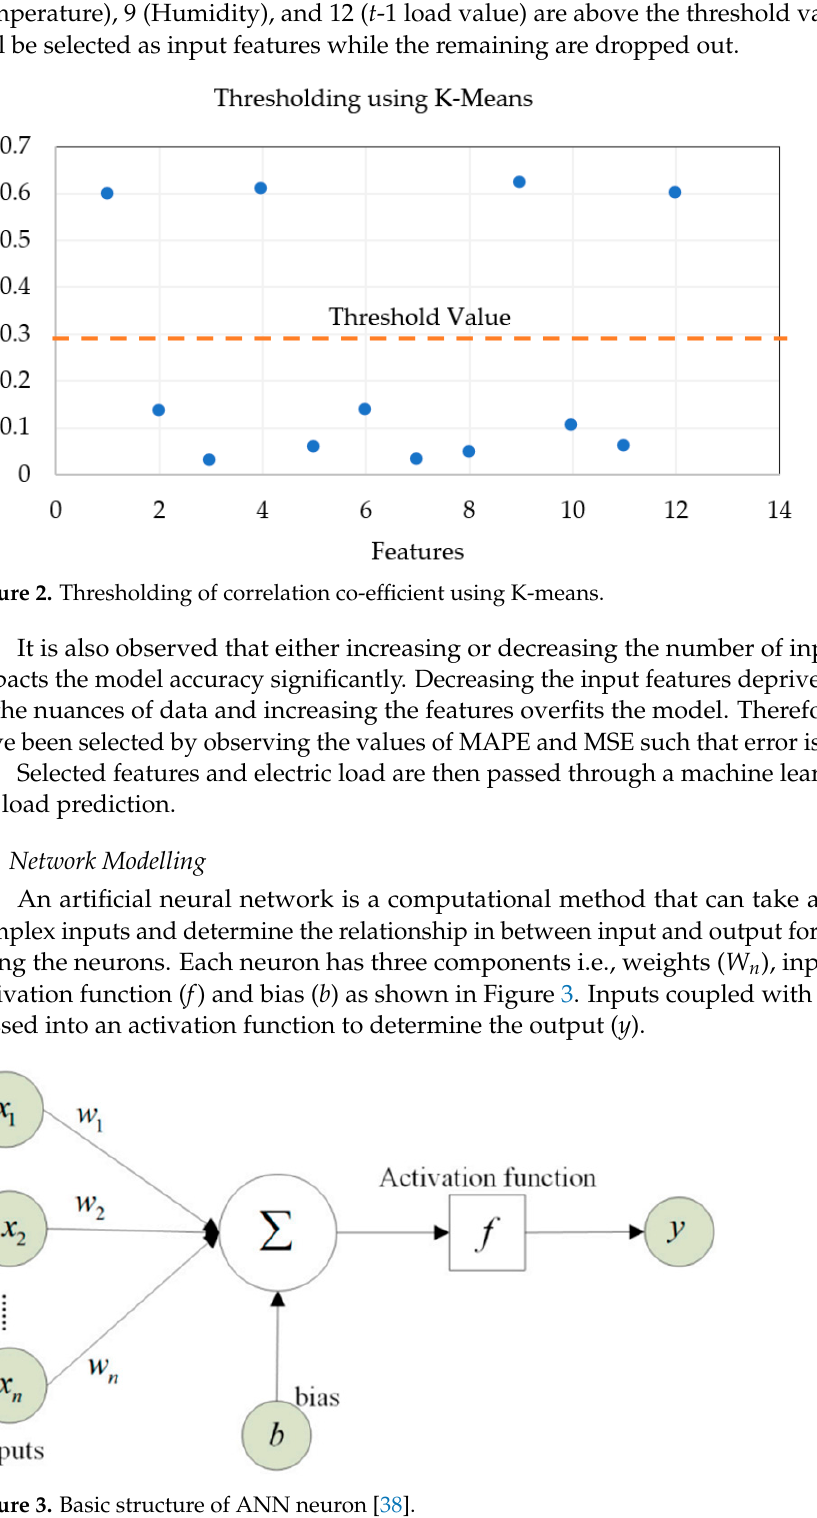
Figure 2. Thresholding of correlation co-efficient using K-means.